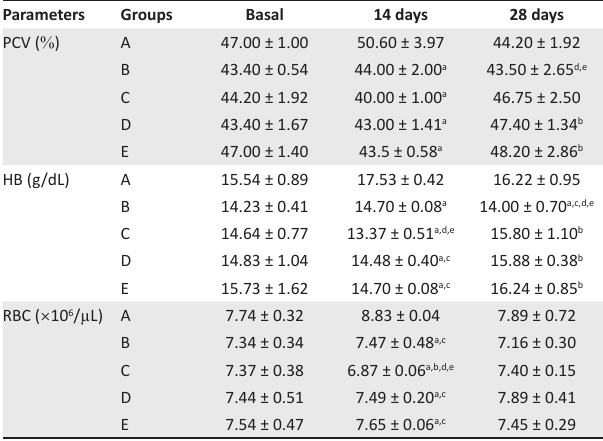
Values are mean ± SD, n = 10, a p < 0.05 compared with control, b p < 0.05 compared with diabetic control, c p < 0.05 compared with glibenclamide, d p < 0.05 compared with MLVA, 200 mg/kg and e p < 0.05 compared with MLVA, 400 mg/kg. PCV, packed cell volume; HB, haemoglobin concentration; RBC, red blood cell count; MLVA, methanol leaf extract of Vernonia